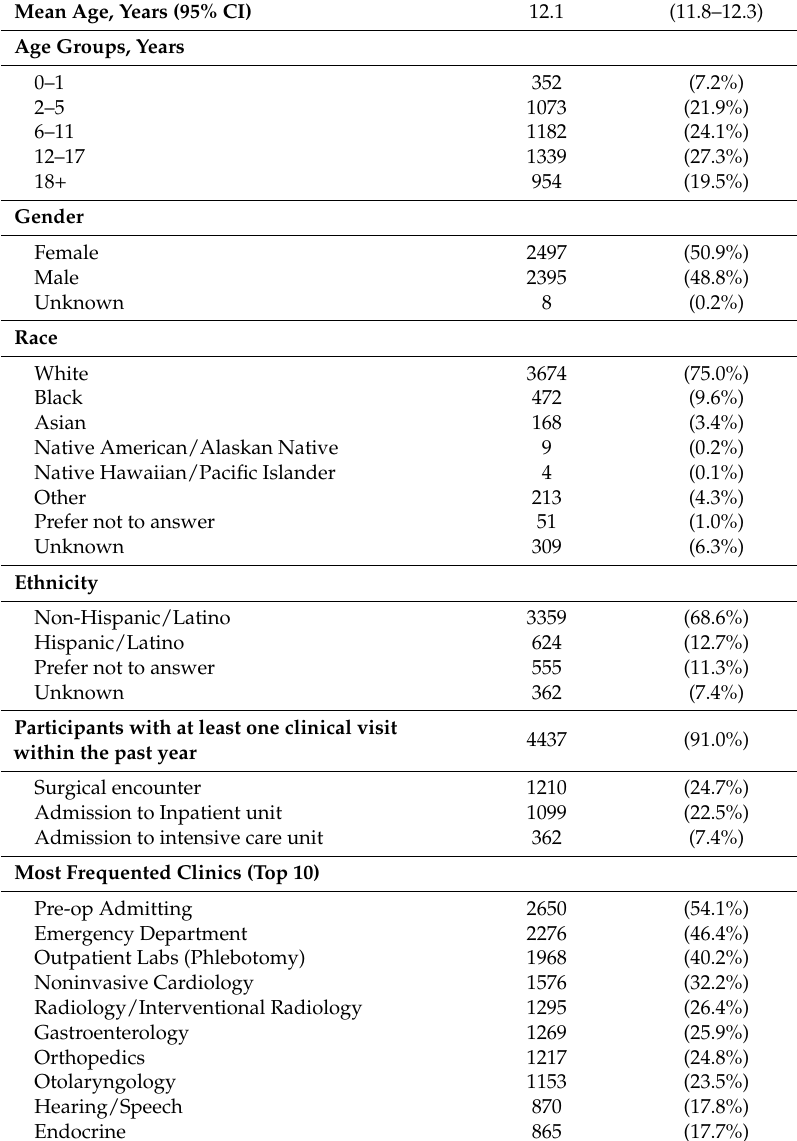
Table 1. Demographic and clinical information of biobank participants ( N = 4900)